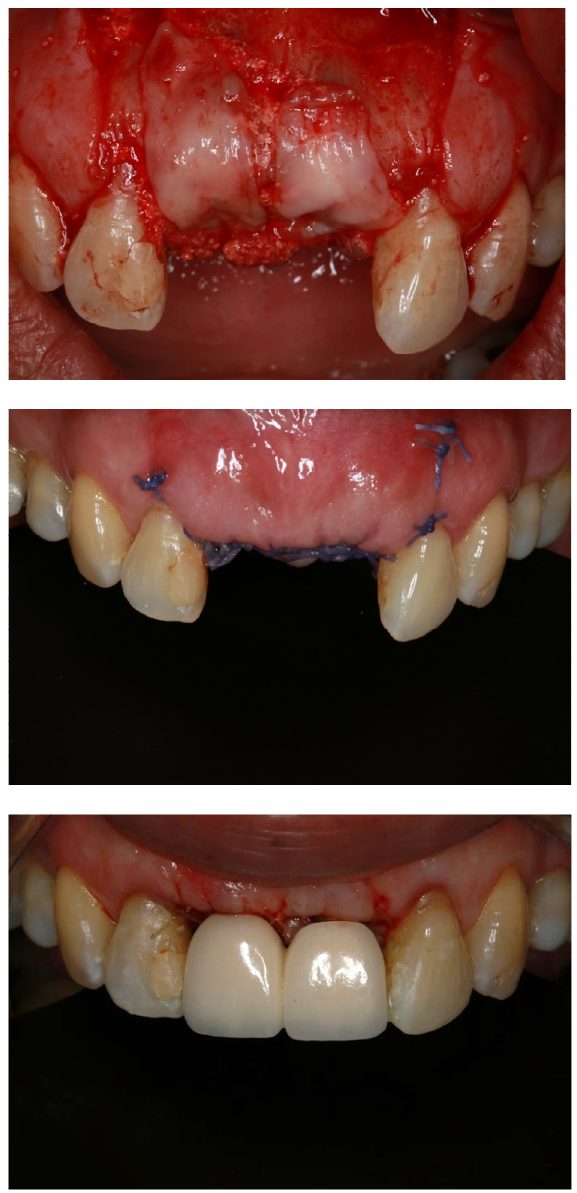
Figure 3. Pictographic series showing a surgical extraction performed to anterior teeth with alveolar ridge preservation, utilizing alveolar bone graft with simultaneous application CGF, which is part of APC. Note that the soft-tissue healed well after 3 weeks, and immediate provisionalization was performed.